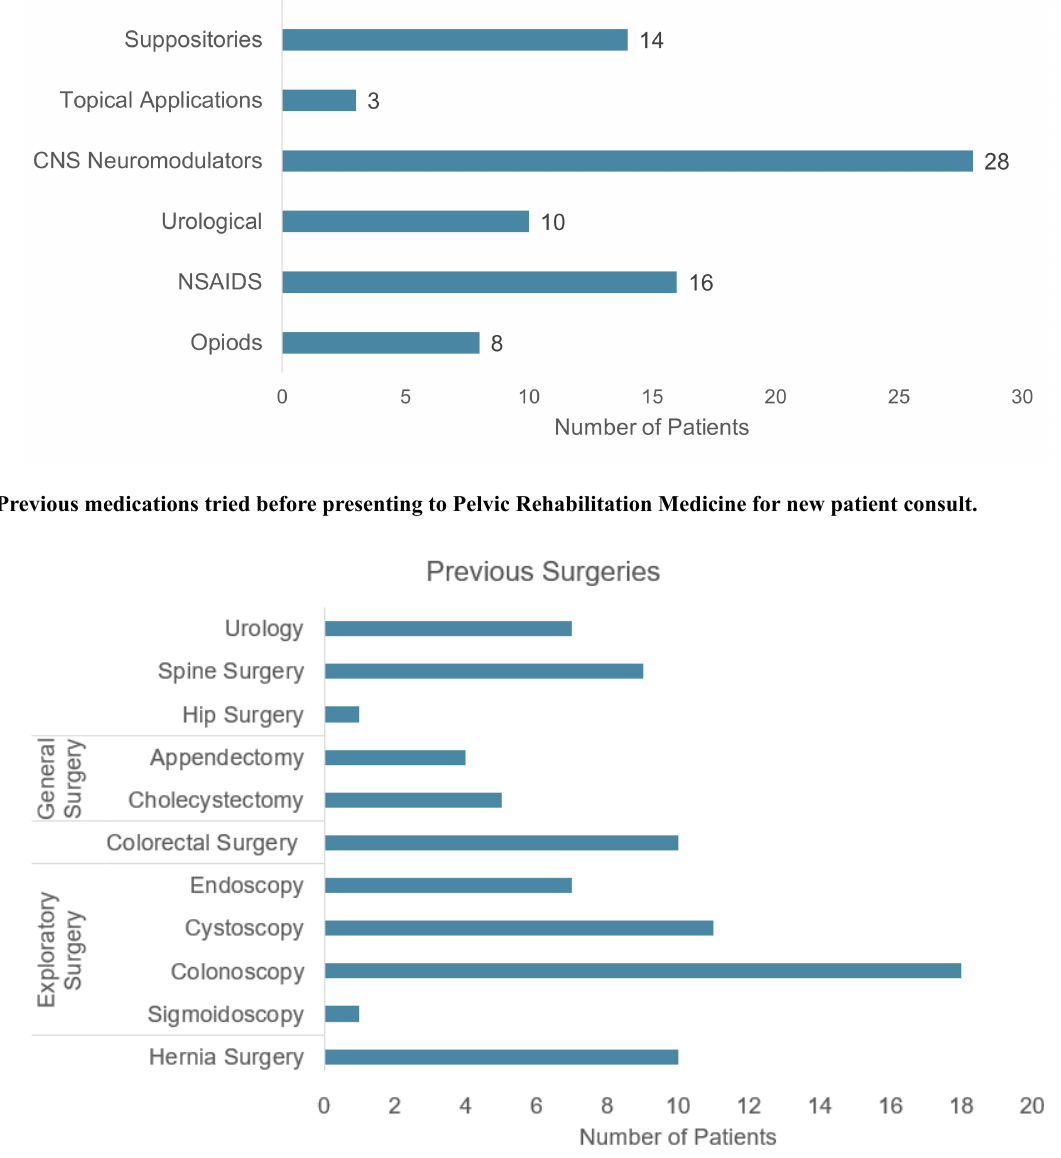
Fig. 2. Previous surgeries underwent before presenting to Pelvic Rehabilitation Medicine for new patient